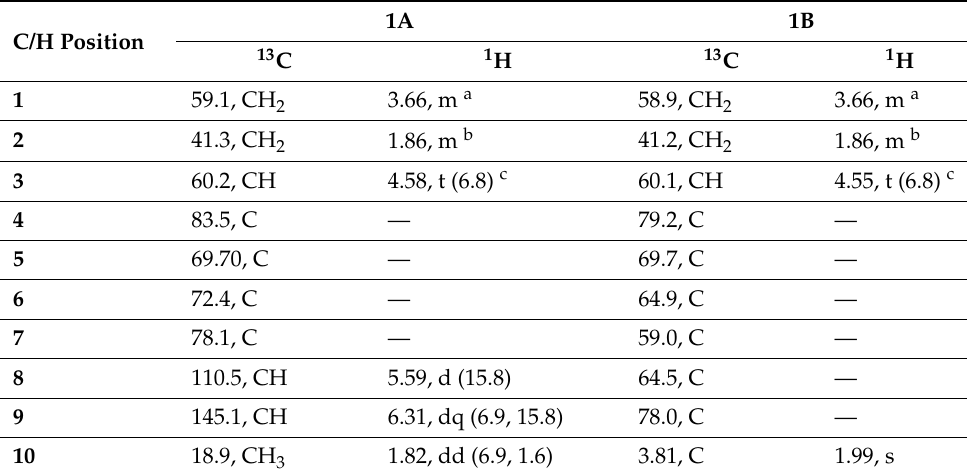
Table 1. 1 H (500 MHz, CD 3 OD) and 13 C (125 MHz, CD 3 OD) NMR spectral data of compounds 1A and 1B ( J in